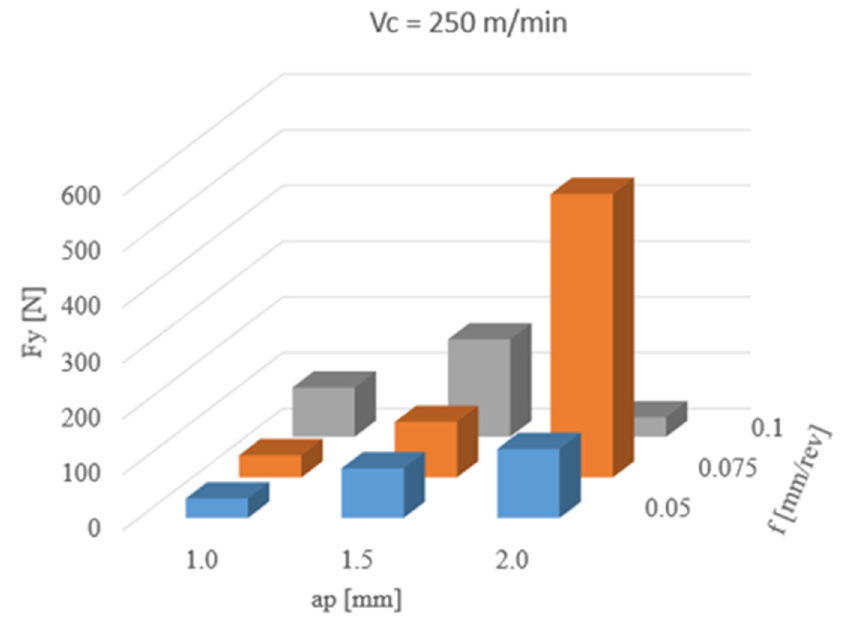
Figure 8. The results of changing cutting parameters on Fy.